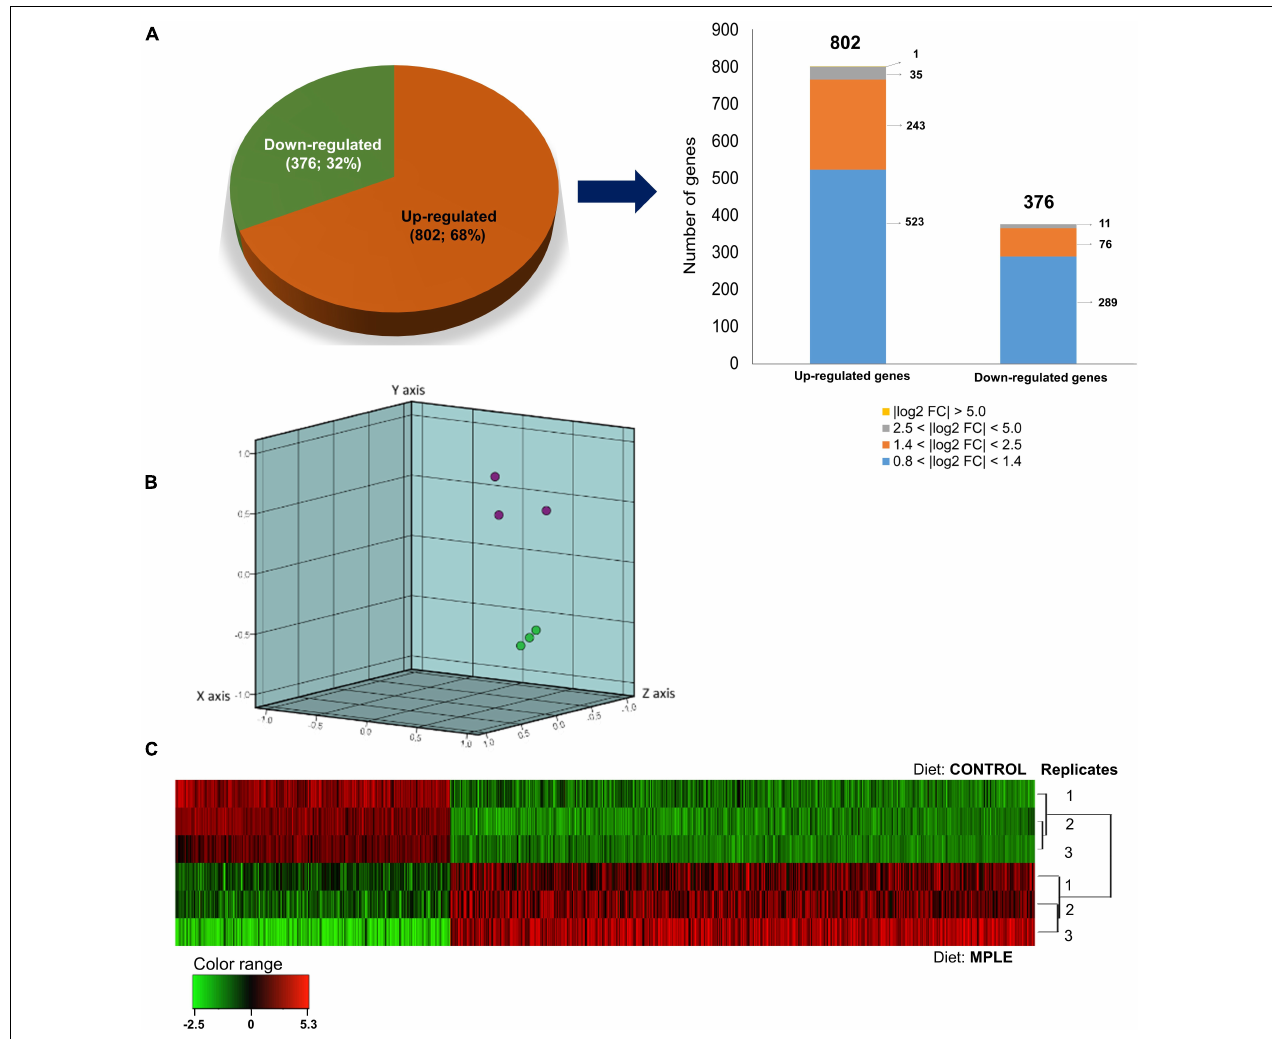
FIGURE 1 | Differential expression analysis of the Atlantic salmon ( S . salar ) head kidney transcriptomic response to MPLE diet. (A) Distribution (pie-chart) of the differential expressed genes (DEGs) obtained from the microarray-based transcriptomic analysis response fed a diet supplemented with phytochemicals from sage and lemon verbena. Absolute log2 fold-change (log2 FC) indicates the magnitude interval of response. (B) Principal component analysis (PCA) of the DEGs for the Atlantic salmon head kidney in response to the control (purple node) and phytogenic-supplemented diet (green node). (C) Hierarchical clustering of the Atlantic salmon head kidney transcriptomic response for the control and MPLE diet, based on similitude patterns of the DEGs detected from three sample pools per dietary group. Data of the six microarrays are depicted. The normalized intensity values (log2) obtained for each microarray analyzed for control (replicate 1, 2, and 3) and MPLE group (replicate 1, 2, and 3) are